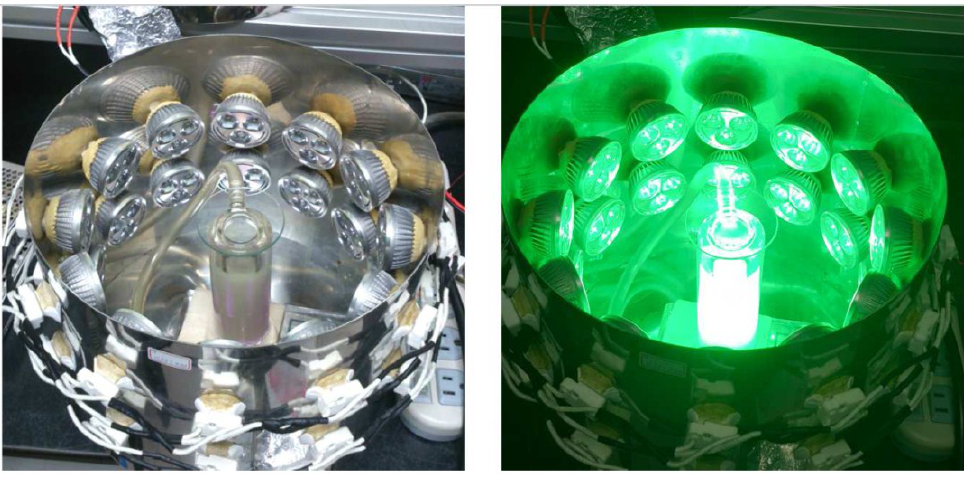
Figure 12. The setup for the temperature-controlled photochemical reaction with green